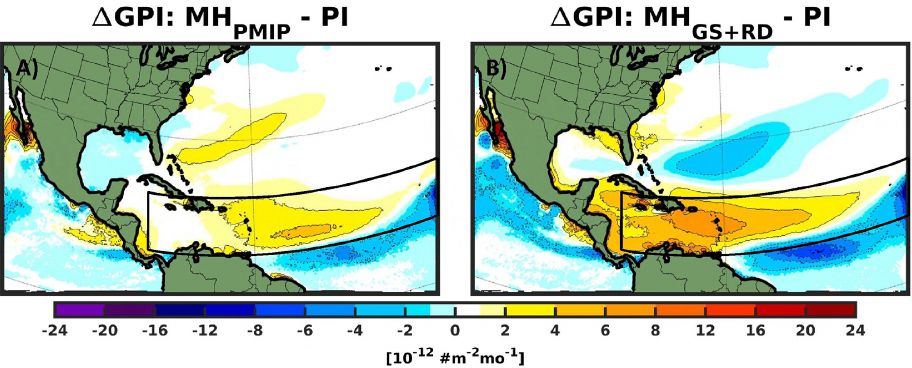
Figure 3. Changes in seasonal GPI (JJASON) for (a) MH PMIP and (b) MH GS + RD experiments relative to PI. The black box shows the approximate present-day MDR. Only values that are significantly different at the 5% level using a local (grid-point) t test are shaded. The contour lines follow the color-bar scale (dashed, negative anomalies; solid, positive anomalies); the 0 line is omitted for